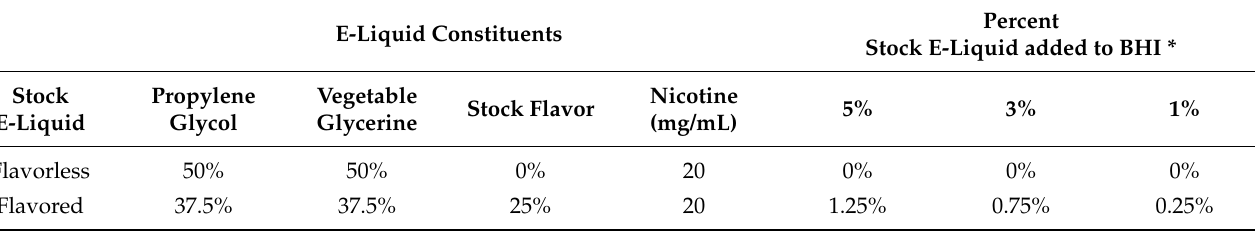
Table 1. Final percentage of flavors in the working BHI